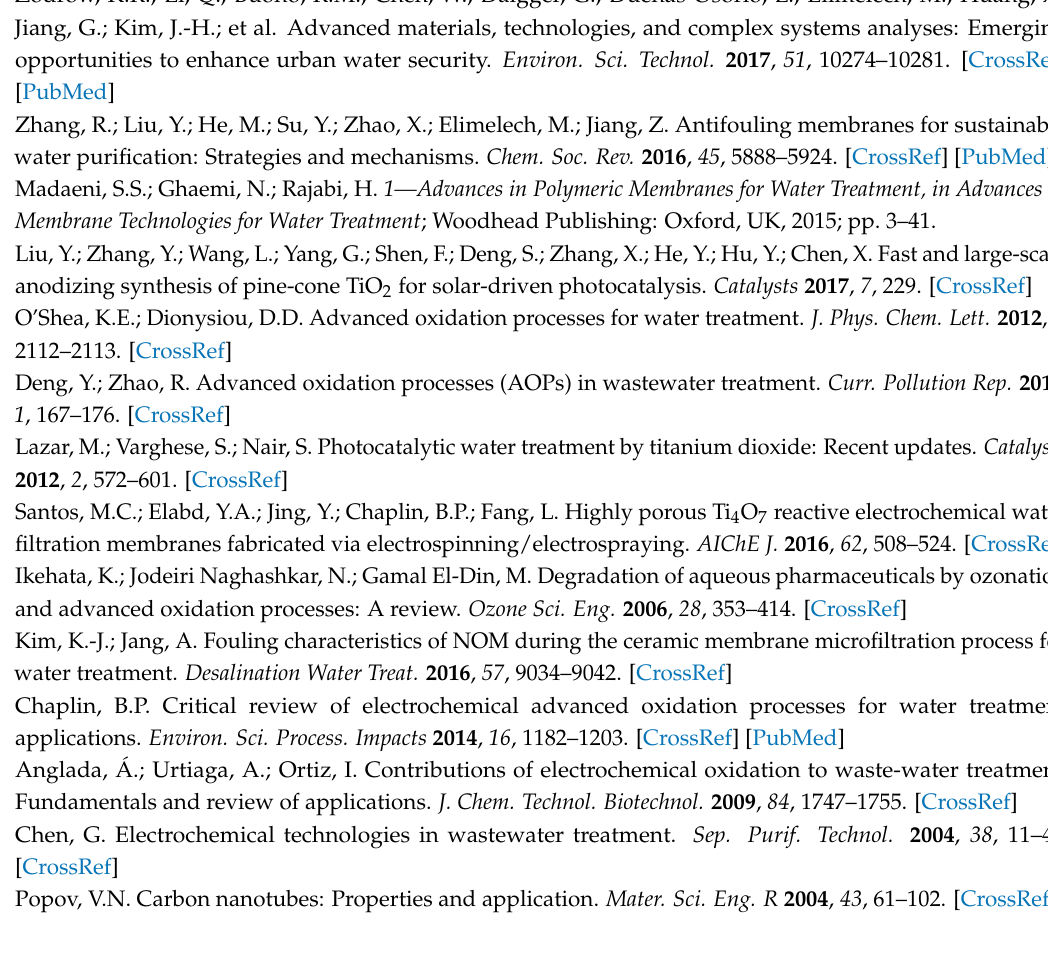
Figure S1: FESEM images of conductive cotton filters fabricated using [CNT] ink = 1.5 mg/mL; Figure S2: Variation of filter resistance of as-fabricated cotton filters with CNT ink concentrations; Figure S3: Demonstration of a CNT cotton filter acts as a conducting path in the emission of an LED indicative lamp under applied voltage of 4 V; Figure S4: MO breakthrough curve under conditions of [MO] in = 0.06 mmol/L, [Na 2 SO 4 ] = 10 mmol/L, and flow rate = 1.5 mL/min; Figure S5. TC breakthrough curves under conditions of [TC] in = 0.2 mmol/L, [Na 2 SO 4 ] = 10 mmol/L, and flow rate = 1.5